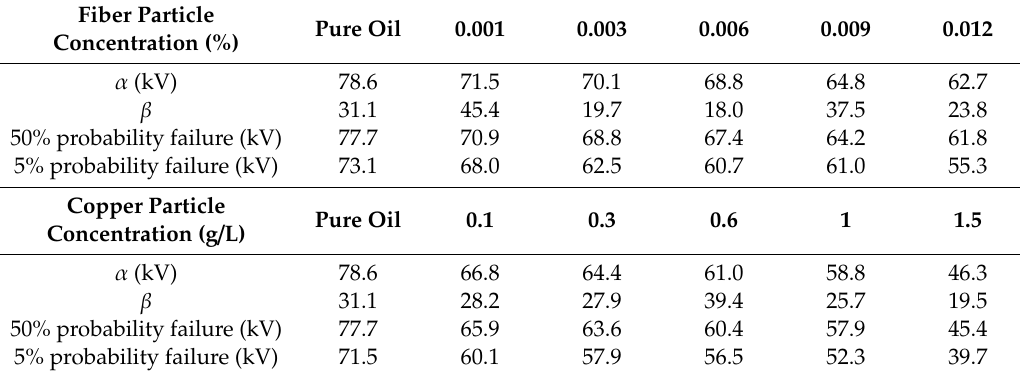
Table 4. Weibull parameter of characteristic DC breakdown for contaminated natural